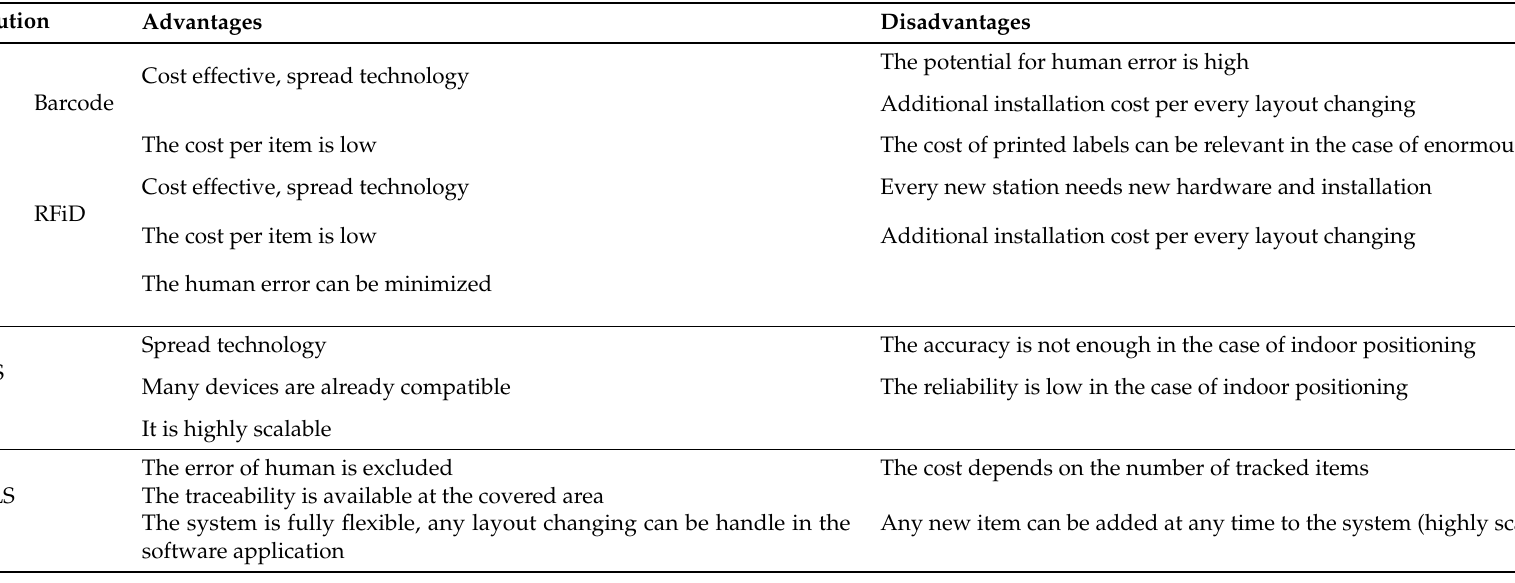
Table 1. The most widely applied solutions for traceability. The advantages and disadvantages help us to choose the right solution for the right layer (see in Figure 2).